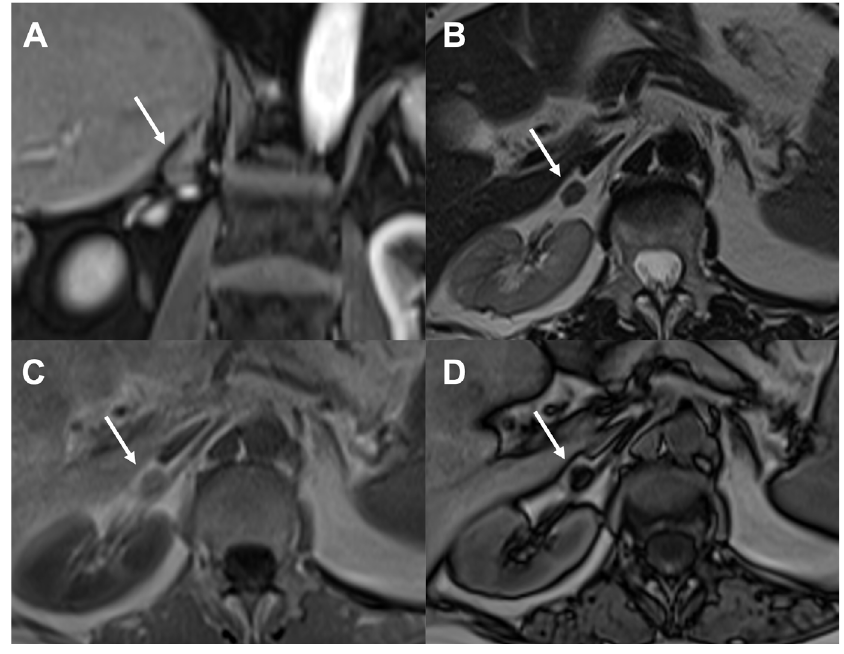
Figure 3 - 47-year-old man in investigation of a rectal lesion. Axial images show a 1.1 cm nodule in the right adrenal gland with no evidence of microscopic fat in in (a) and out-of-phase (b) images. The lesion was hypointense lesion on T2-weighted (not show), with hypervascular enhancement (c) and washout on delayed imaging (d). Absolute washout was calculated at